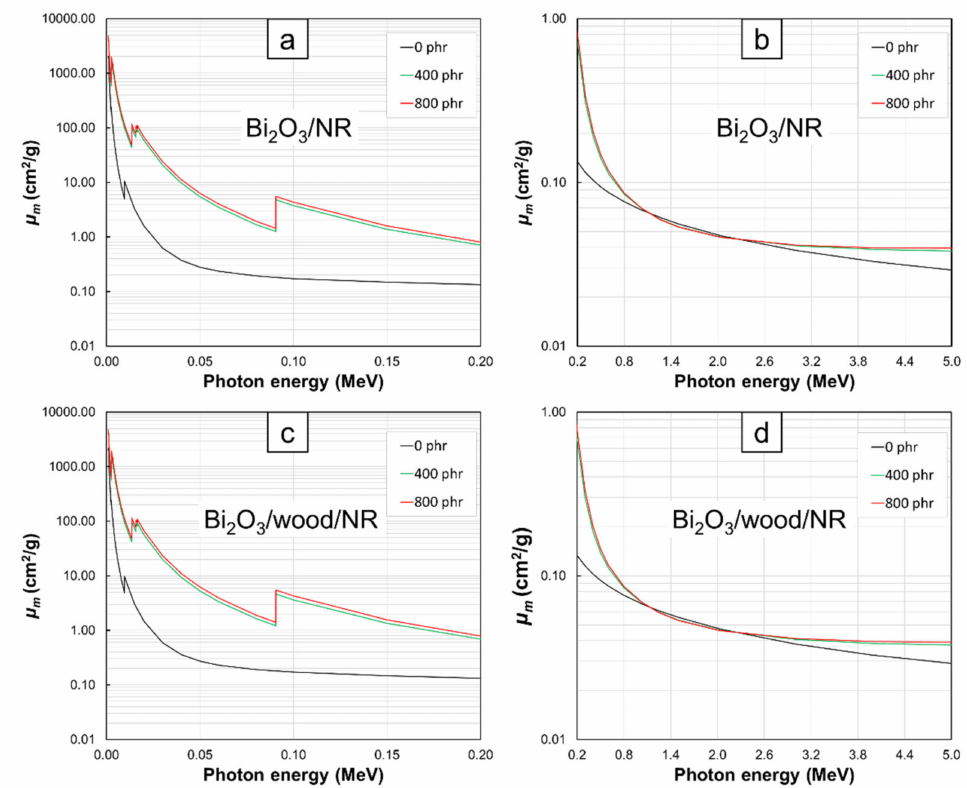
Figure 1. µ m values of ( a , b ) Bi 2 O 3 /NR and ( c , d ) Bi 2 O 3 /wood/NR composites with filler contents of 0, 400, and 800 phr, determined at photon energies of ( a , c ) 0.001–0.2 MeV and ( b , d ) 0.2–5 MeV using XCOM. Raw data are provided in the Supplementary Materials (Tables S1, S2, S3, S8, S9, and